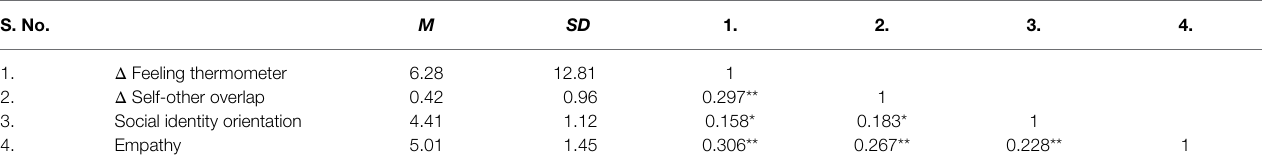
TABLE 1 | Descriptive statistics and correlations between the feeling thermometer change scores, self-other overlap change scores, social identity orientation (SIO), and empathy. S.